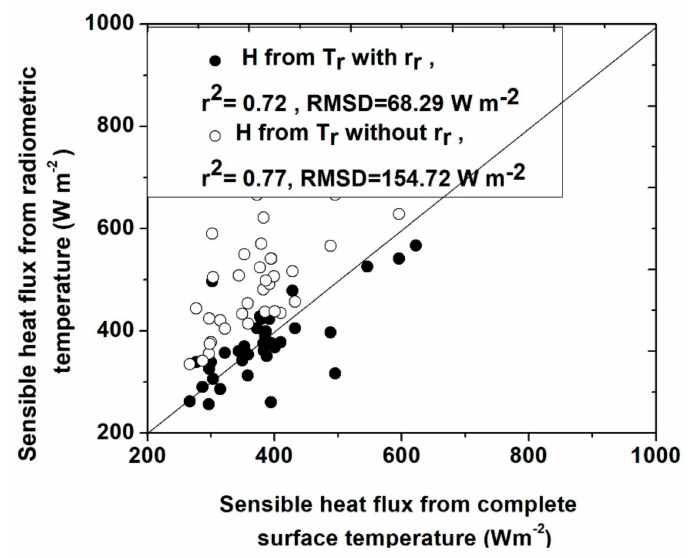
Figure 7. Sensible heat flux estimated by Equations (2) and